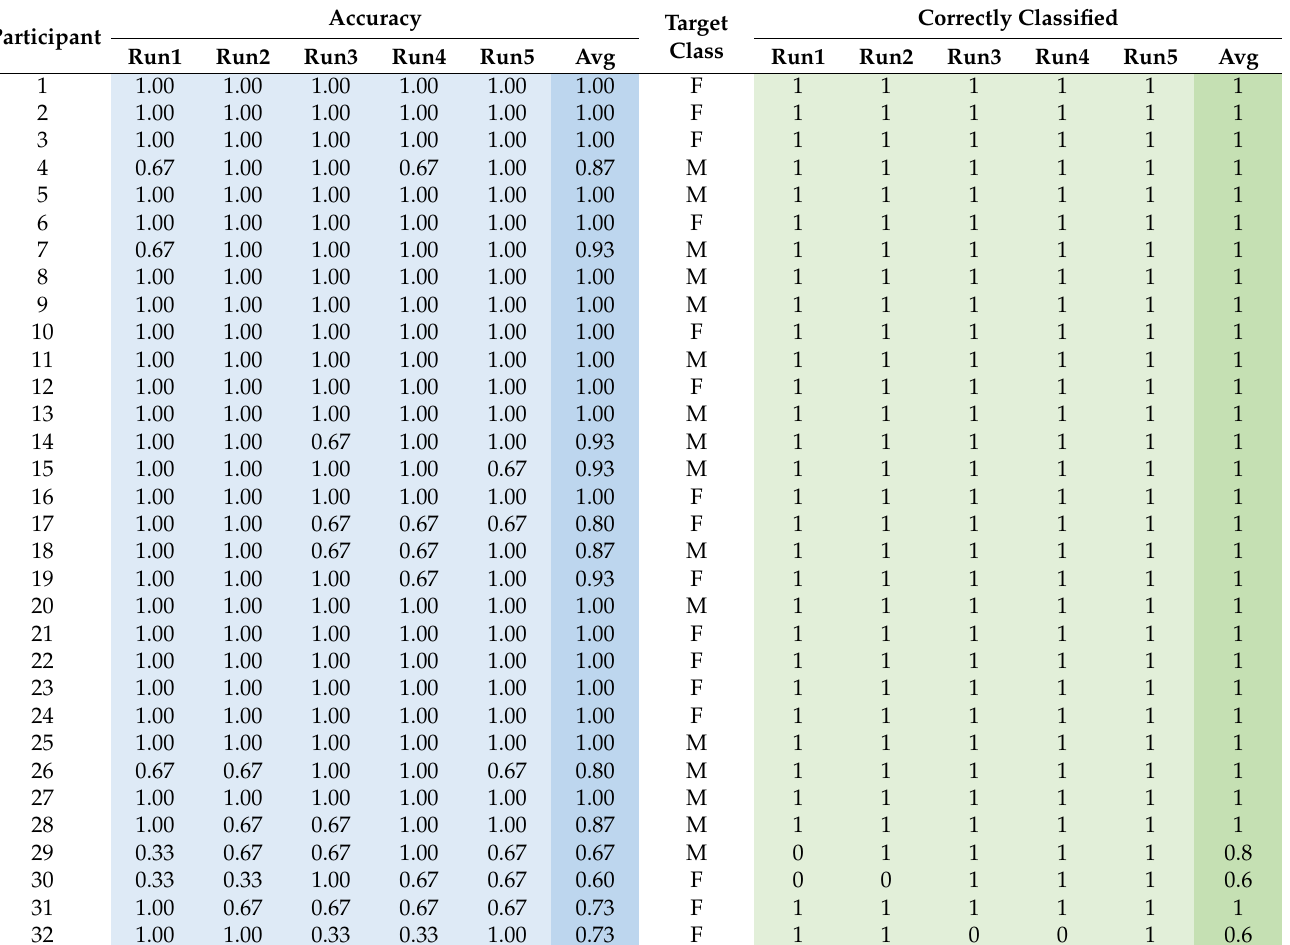
Table 5. Classification accuracies on the test data for alert